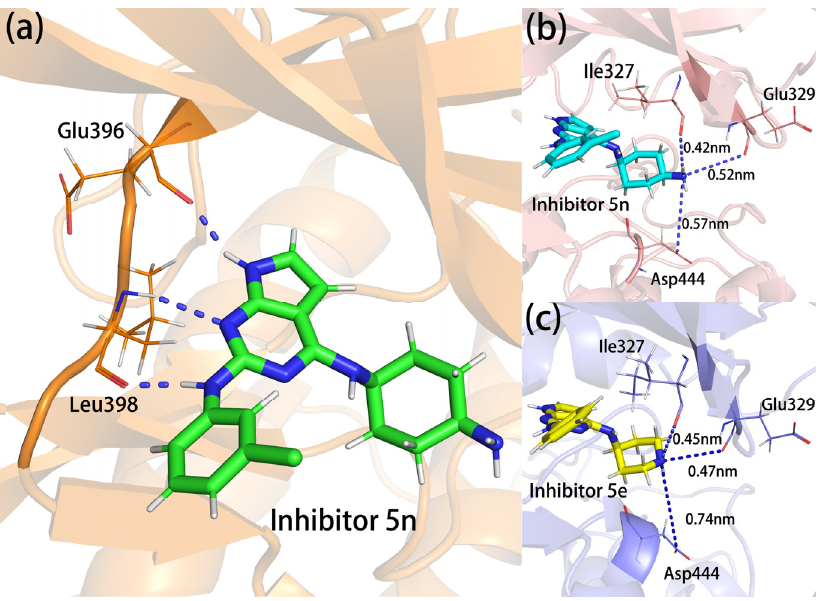
Figure 7. ( a ) The structure of the triple hydrogen bonds in the hinge region; ( b , c ) the distances Figure 7. (a) The structure of the triple hydrogen bonds in the hinge region; (b-c) the distances between Ile327, Glu329, Asp444, and inhibitors 5n and between Ile327, Glu329, Asp444, and inhibitors 5n and 5e.